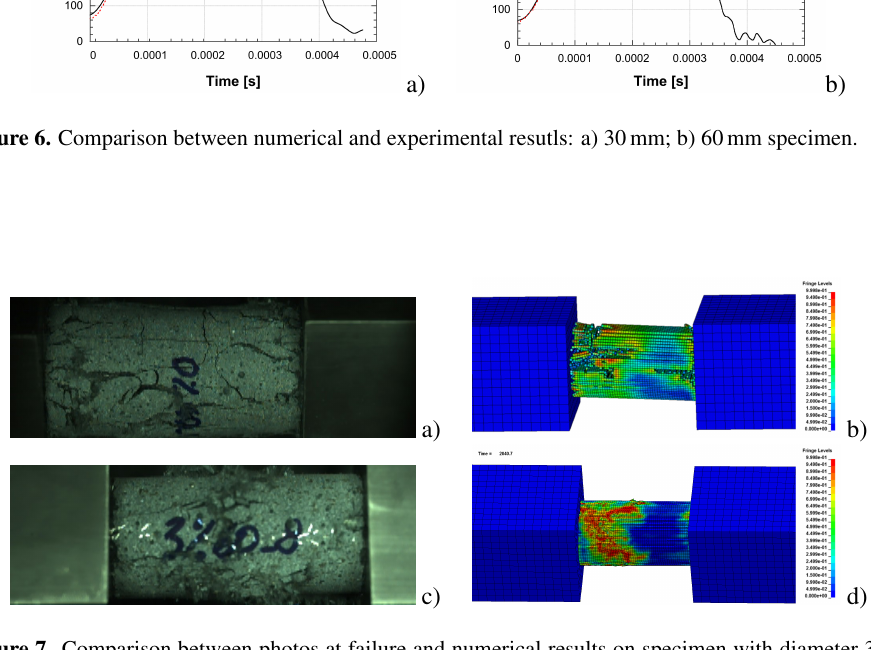
Figure 7. Comparison between photos at failure and numerical results on specimen with diameter 30 mm and height 60 mm of UHPC (a and b) and UHPFRC (c and